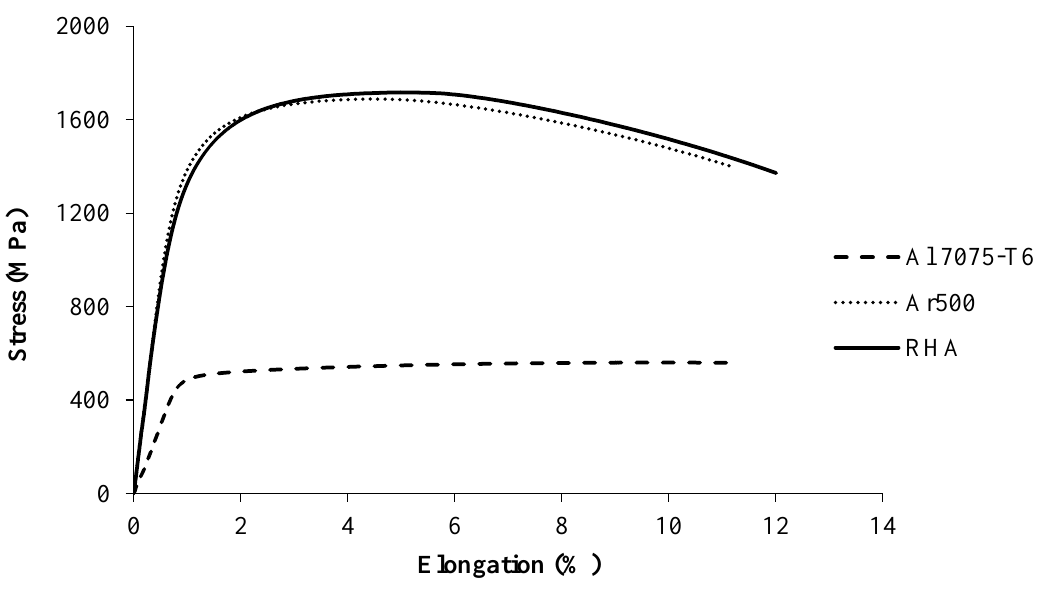
Figure 7. Stress–strain curves for RHA, Ar500 and Al7075-T6 at 1.5 mm/min. Table 3. The mechanical properties of RHA, Ar500 and Al7075-T6.